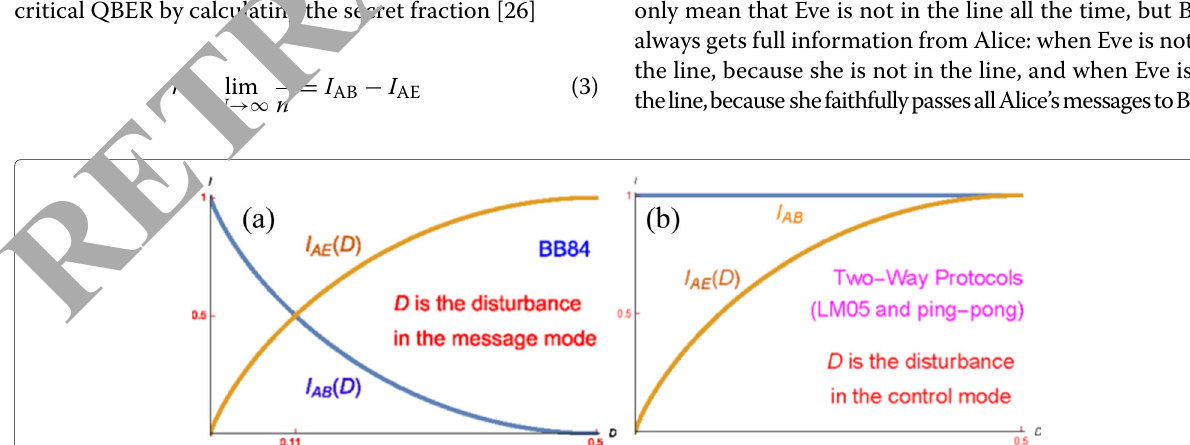
Fig. 5 Mutual information plots for BB84 vs. two-way deterministic protocols. a One-way probabilistic protocol BB84. b Two-way deterministic protocols with either entangled Bell states or with LM05-like single photon states. Essential difference between them is that in a Eve causes polarization flips in the message mode, while in b Eve ideally does not cause any flip in the message